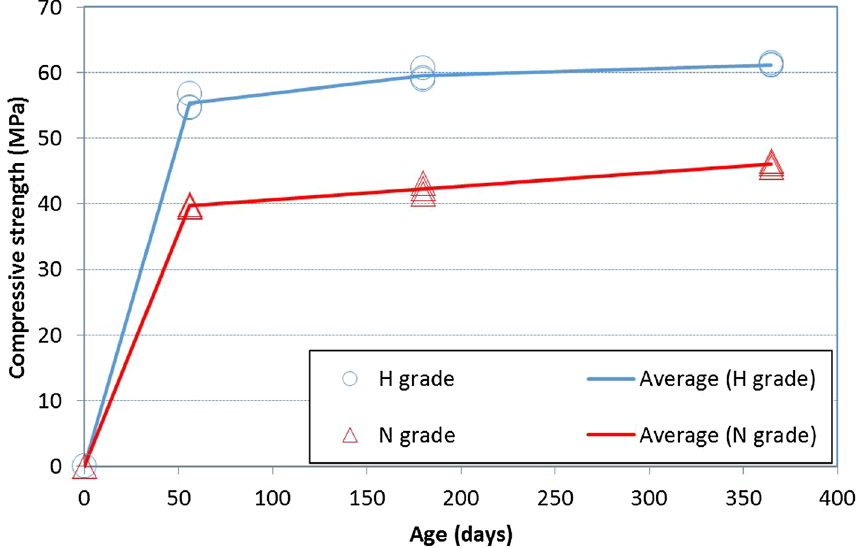
Fig. 3 Changes in compressive strength with different curing